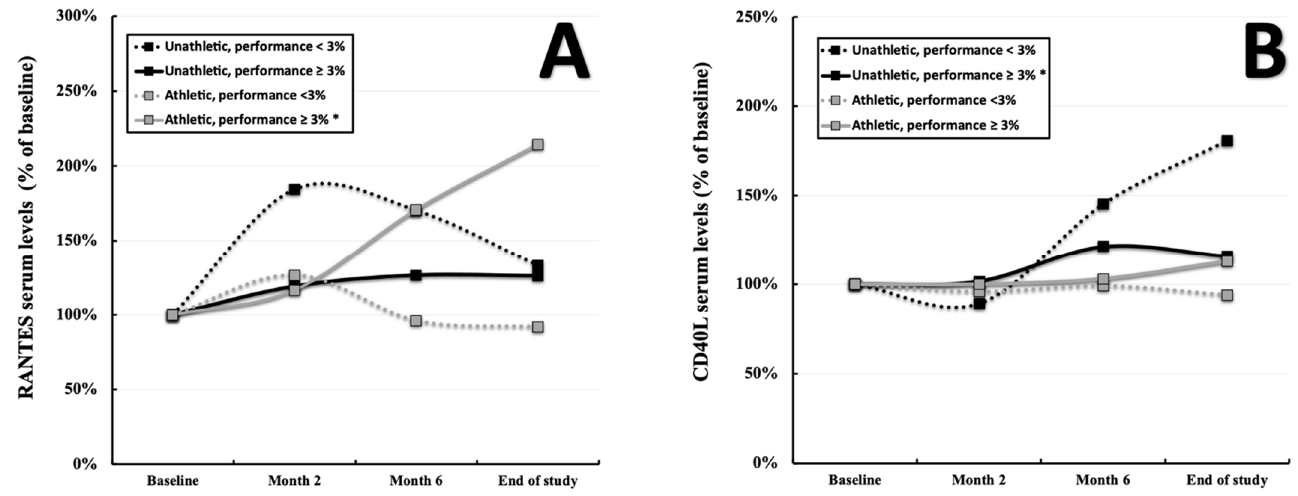
Figure 2. Progression of RANTES ( A ) and CD40L ( B ) serum levels within the subgroups α (initial performance < 100%, performance gain ≤ 2.9%, n = 9), β (initial performance < 100%, performance gain > 2.9%, n = 32), γ (initial performance ≥ 100%, performance gain ≤ 2.9%, n = 18), and δ